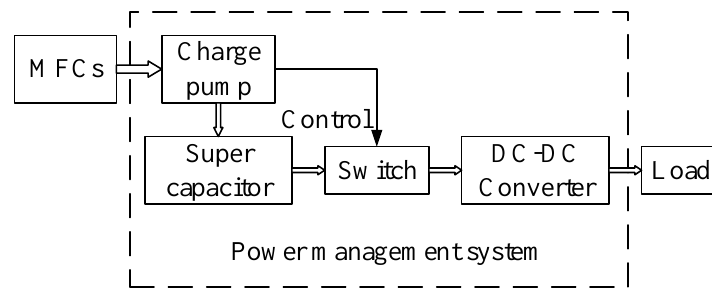
Figure 1. Schematic of the PMS.